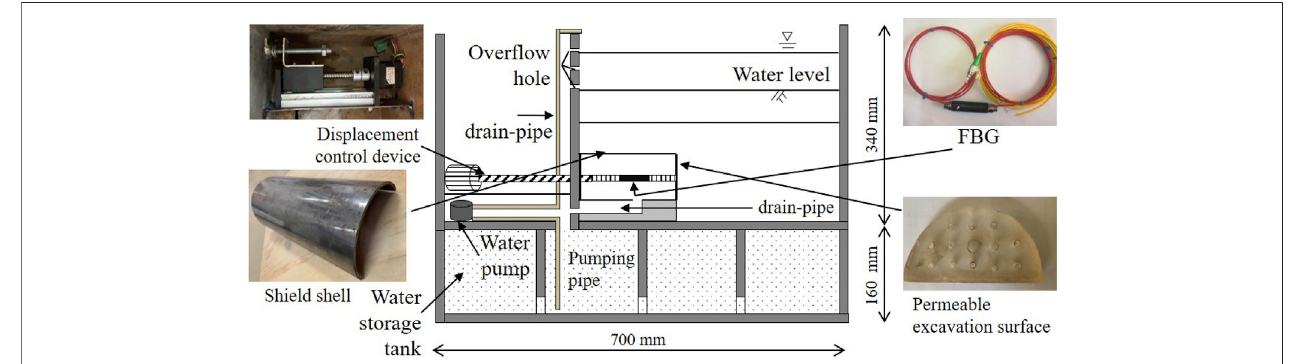
FIGURE 2 | Centrifugal test model box for stability of shield tunnel excavation